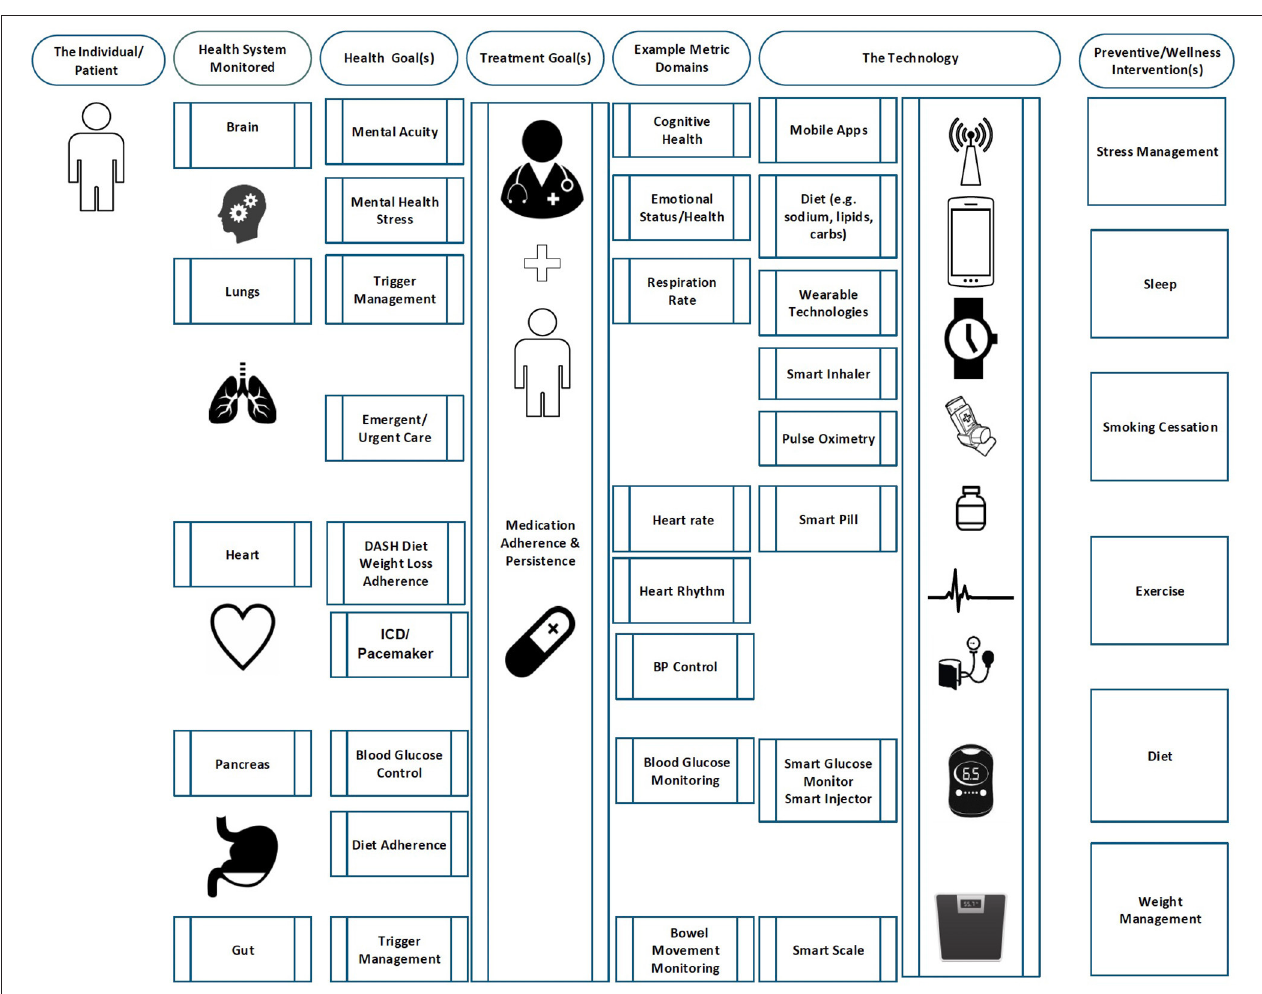
FIGURE 1 | This map describes one set of possibilities for configuring a digital twin with existing